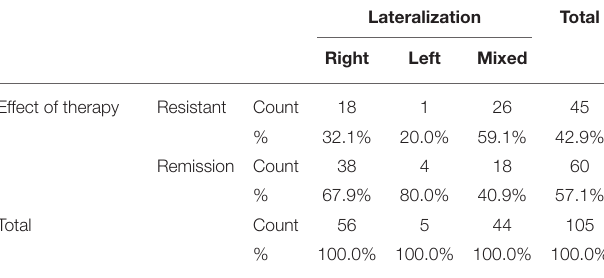
TABLE 2 | Relationship between functional dominance of the foot and the effectiveness of therapy.